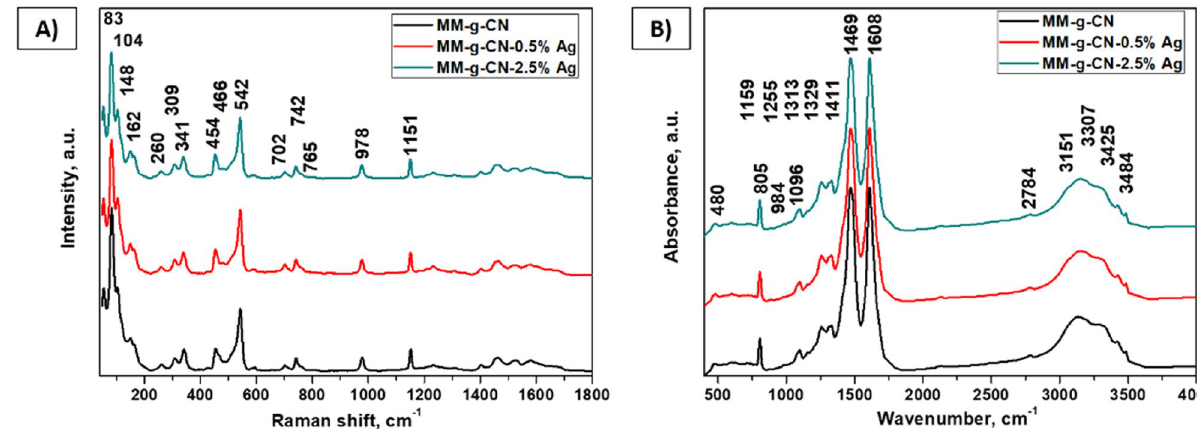
Figure 4. Raman ( A ) and IR ( B ) spectra of pure MM-g-CN and MM-g-CN-0.5% Ag and MM-g-CN-2.5% Ag powders, where most intensive bands are